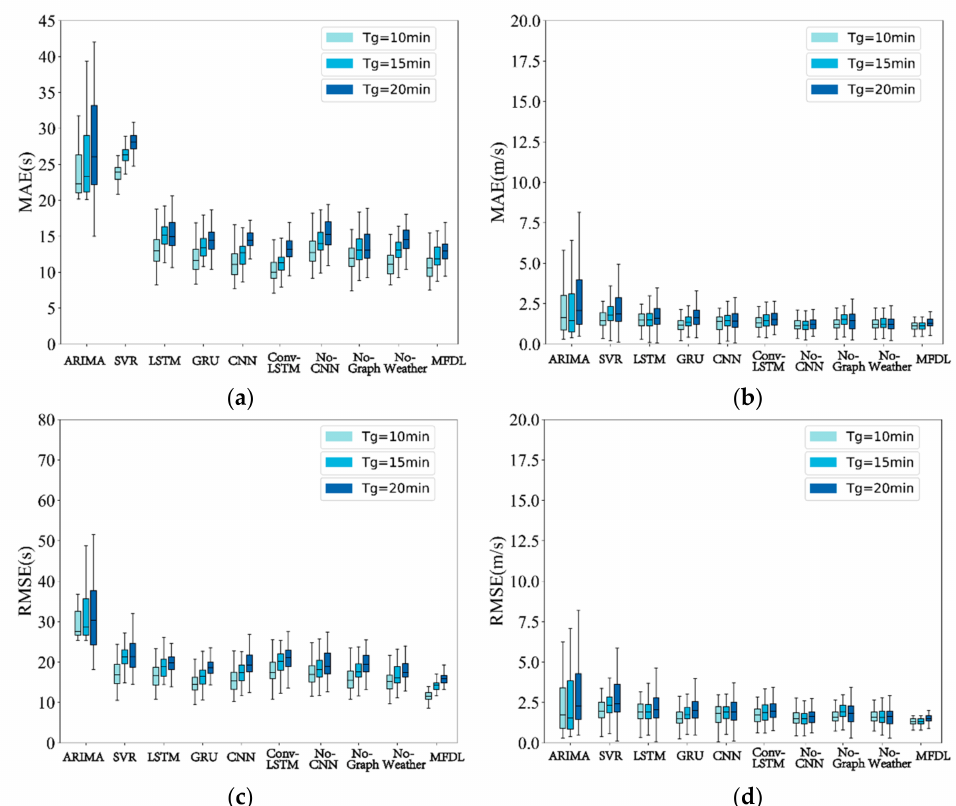
Figure 14. Comparison of the prediction errors for each method. ( a ) MAE of the predicted passing time; ( b ) MAE of the predicted speed; ( c ) RMSE of the predicted passing time; ( d ) RMSE of the predicted speed.